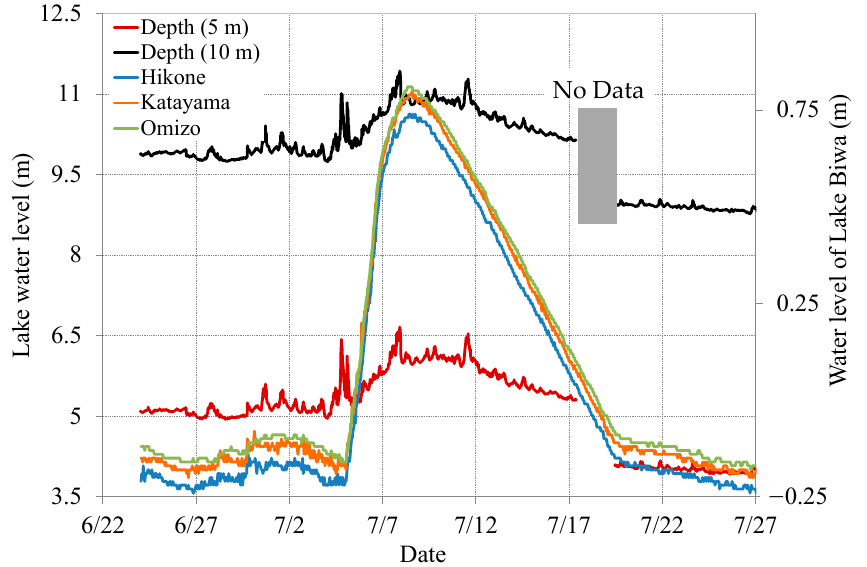
Figure A1. Time series comparison of the observed data obtained using a depth metre near the surface (5 and 10 m) of the lake and water level data of MLIT.